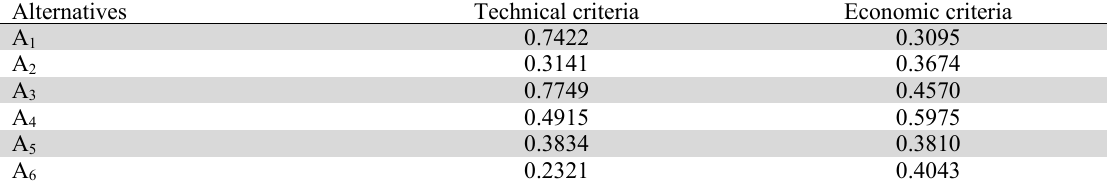
Closeness coefficients for using technical and economic criteria Alternatives Technical criteria